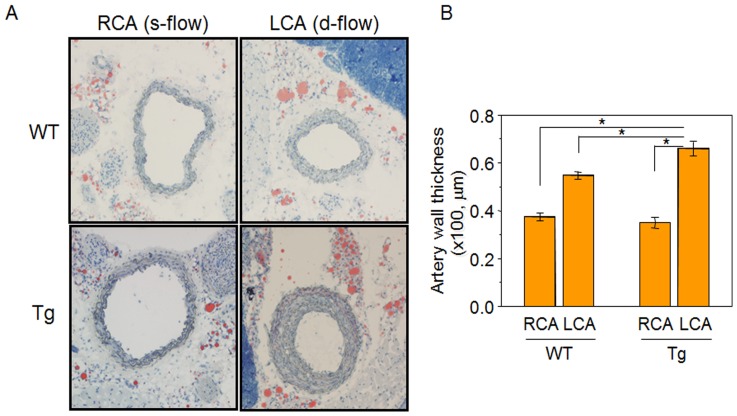
Enhanced carotid wall thickening by increased nuclear Trx1 in NLS-Trx1 Tg mice.The 11 mice for each WT and NLS-Trx1 Tg were partially ligated in left carotid artery [LCA, disturbed (d)-flow] while RCA [steady (s)-flow] was left intact and examined for carotid wall thickening by histology using Oil Red O staining on frozen sections (A). A bar graph (B) shows wall thickness measured using NIH image J software. Data are means ± SE (* p<0.05).